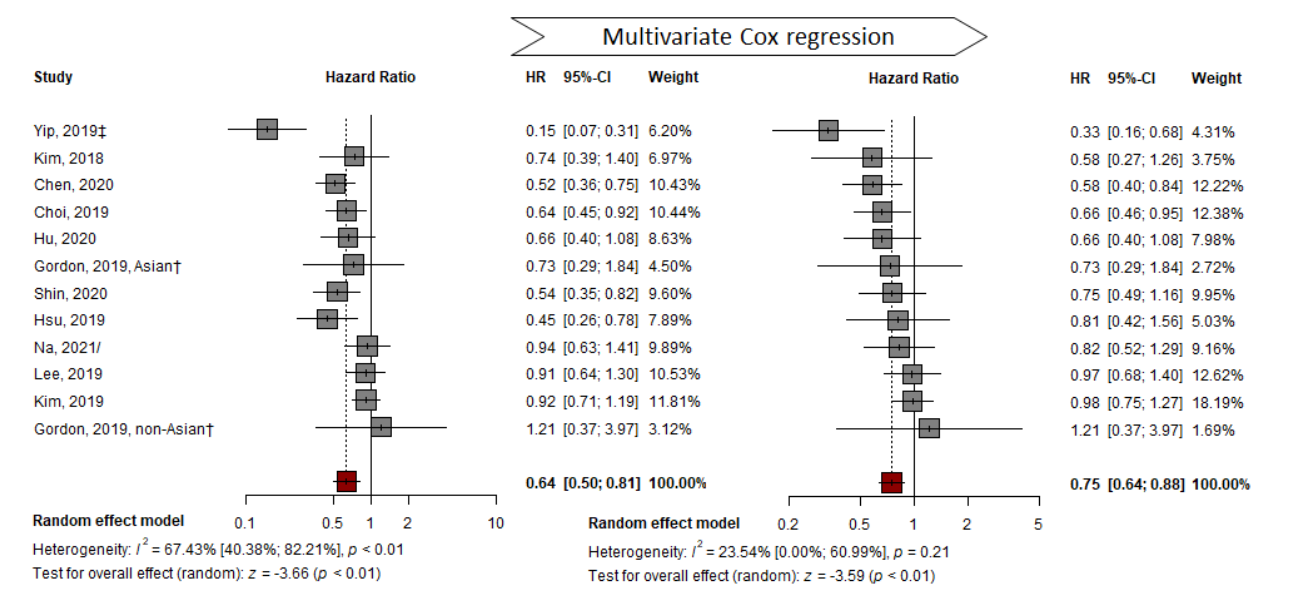
Figure 3. Multivariable adjusted HR pooled analysis comparing the effectiveness of TDF vs. ETV at reducing HCC development. HR: hazard ratio; † abstract; ‡ suggest outcomes from competing risk analysis;/from unadjusted cohort at the time of CVR [7,23–27,29,33,38–40].